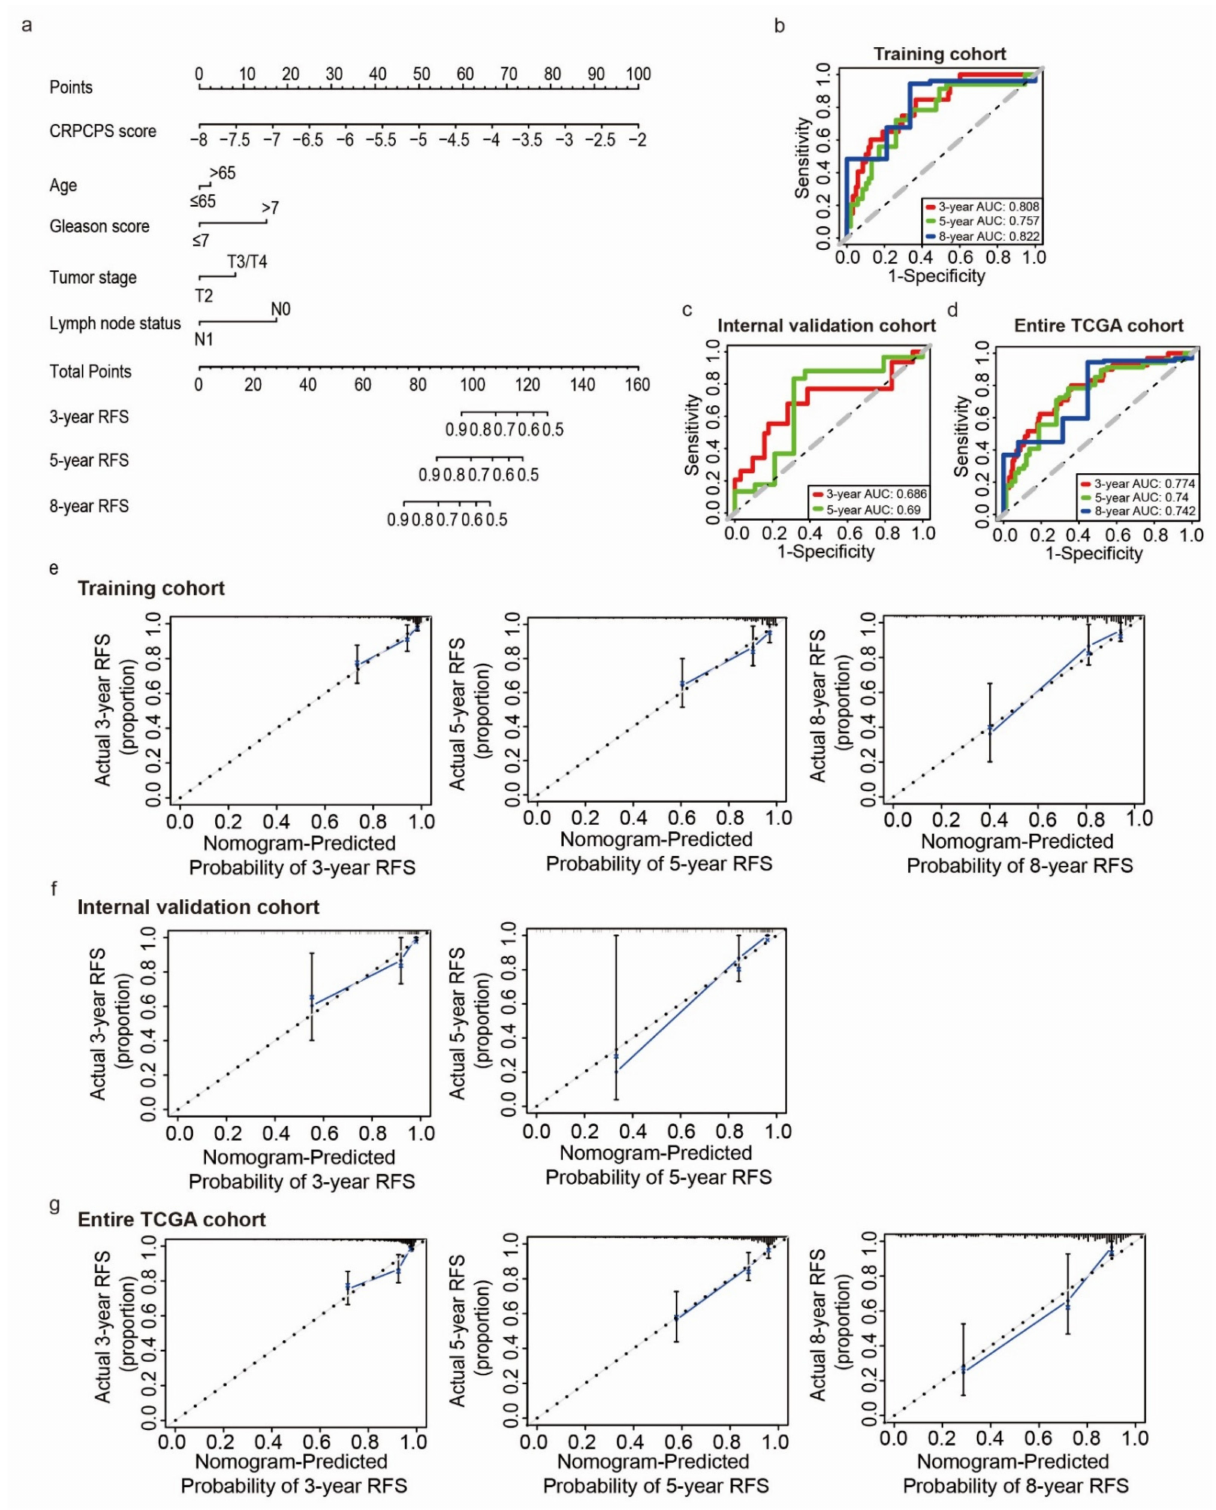
Figure 11. Nomogram construction and evaluation for predicting 3-, 5-, and 8-year RFS in PCa. ( a ) Nomogram construction for the 3-, 5-, and 8-year RFS probability prediction in the TCGA training cohort. ROC curves evaluated the efficiency of the nomogram for predicting 3-, 5-, and 8-year RFS in the TCGA training cohort ( b ), the internal validation cohort ( c ), and the entire TCGA cohort ( d ). Calibration plots of the nomogram for predicting the probability of RFS at 3 (left), 5 (center), and 8 years (right) in the TCGA training cohort ( e ), the internal validation cohort ( f ), and the entire TCGA cohort ( g